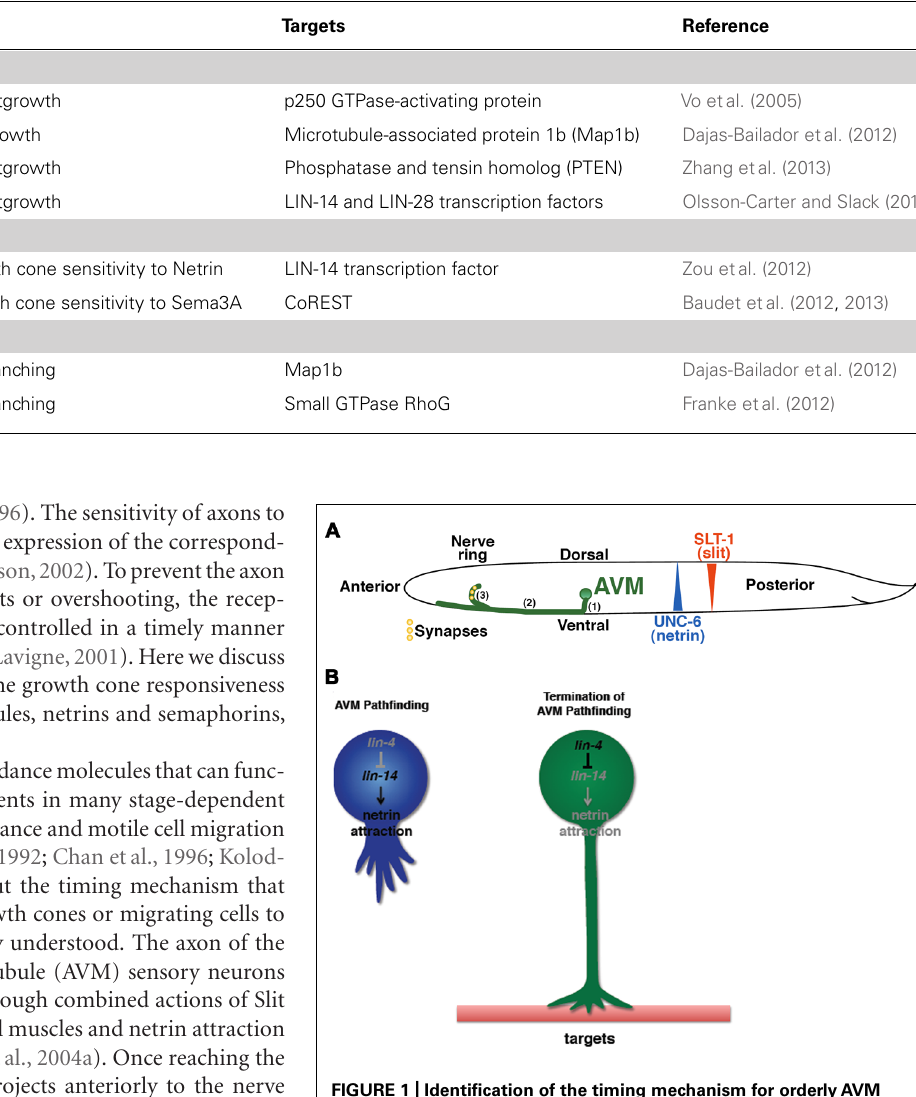
FIGURE 1 | Identification of the timing mechanism for orderlyAVM axon connectivity . (A) Sequential events of AVM axon outgrowth and synapse formation in the first larval (L1) stage of C. elegans . (1) Axon grows ventrally. (2) Axon grows anteriorly. (3) End of axon pathfinding